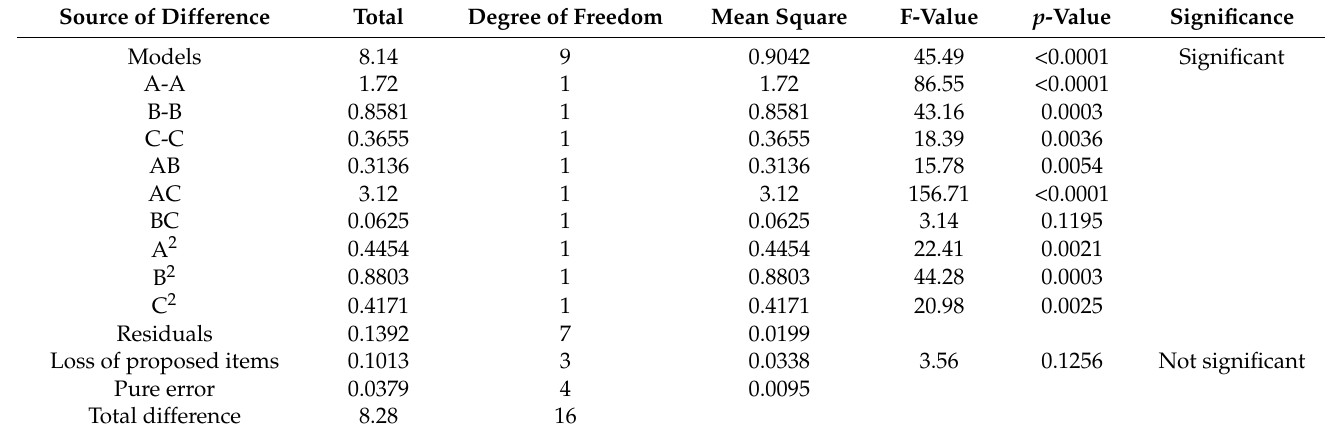
Table 8. Box–Behnken response surface variance analysis results of Lan tea